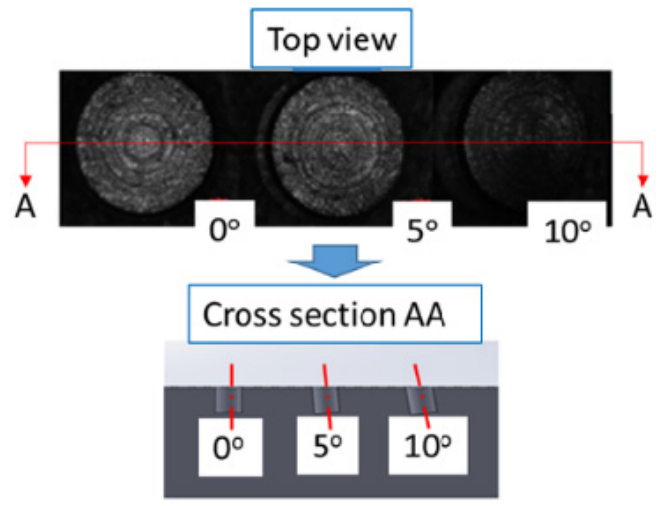
Figure 18. Micro hole with different tilting angles.